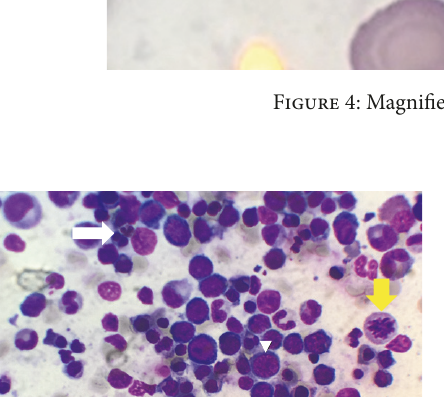
Figure 5: Bone marrow smear showing multinucleated red cell (white arrow), typical megaloblast (arrowhead), and mitotic phase cell (yellow arrow).